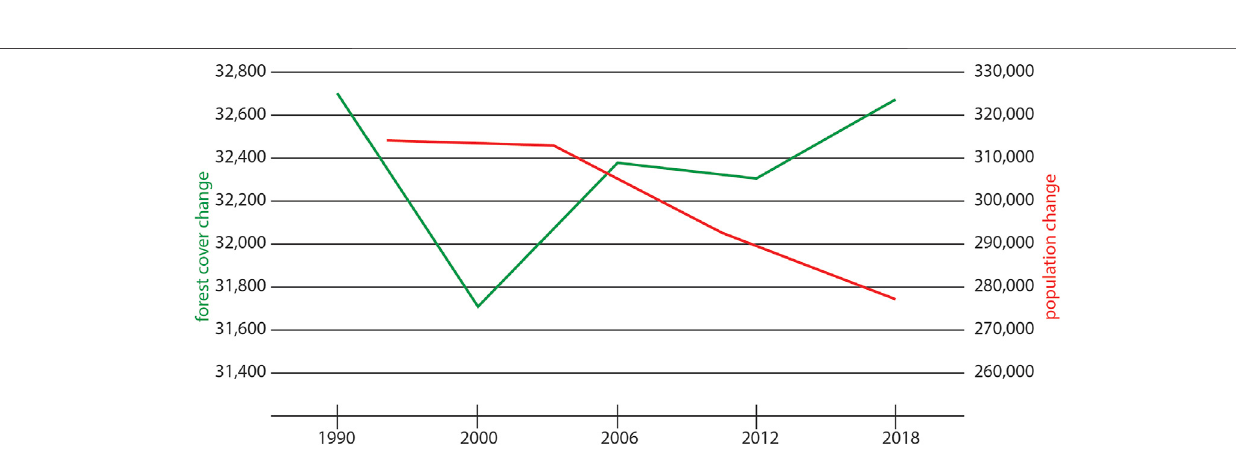
Frontiers in Environmental Science |